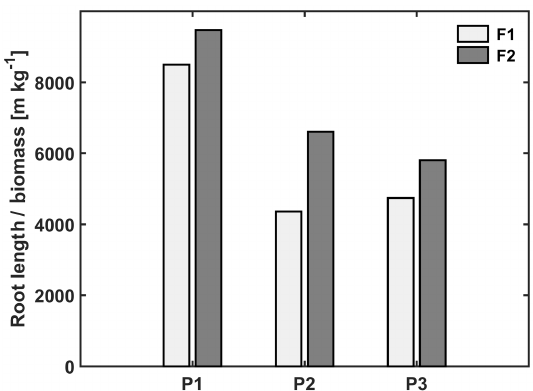
Figure 4. Ratio of total root length to biomass in the three plots (P1: sheltered; P2: rainfed; P3: irrigated) of the stony (F1) and silty (F2)